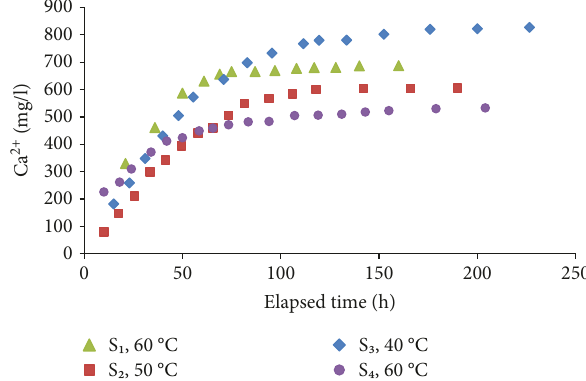
Figure 4: Variation in the Ca 2+ concentration over time in the solubility measurement